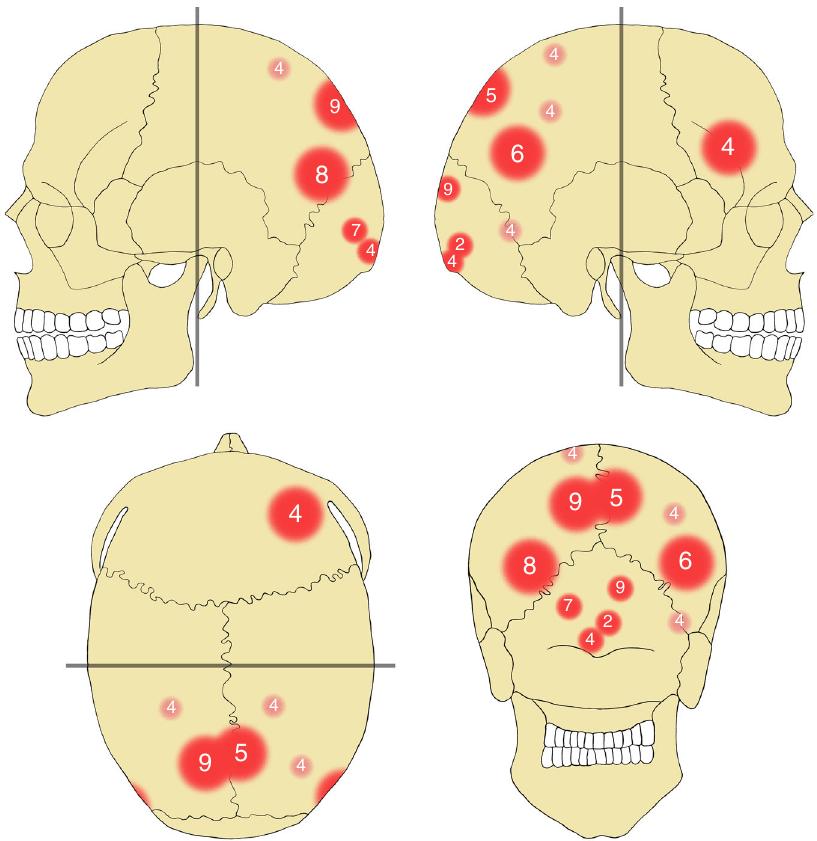
Fig. 3 Compilation of the approximate locations of cranial trauma. Signature size represents general trauma size (large vs. small), darker shading represents securely identi fi ed trauma, lighter shading represents likely trauma. Signature locations indicate approximate points of initial impact. Numbers indicate the affected individuals with skulls preserved (ind. 2; inds 4 – 9)